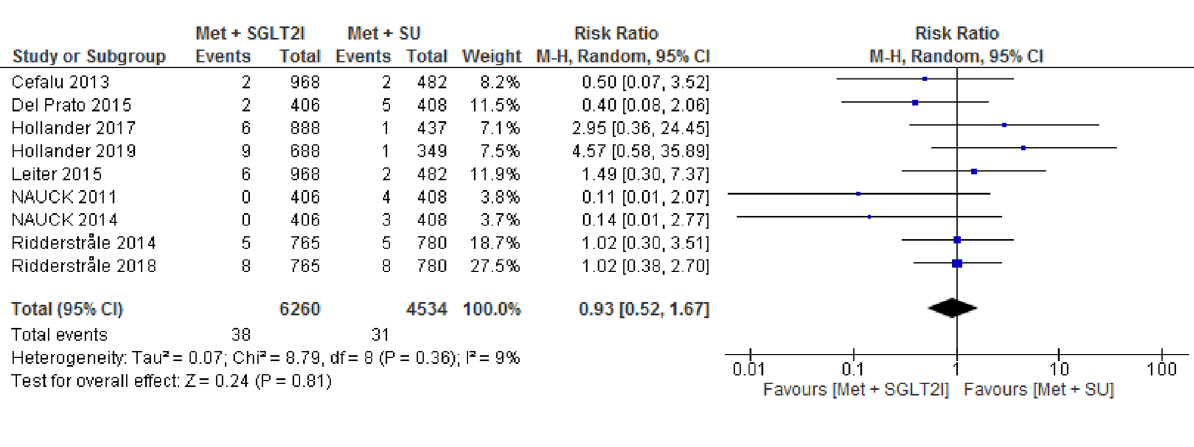
Figure 2. ’Risk of bias’ summary: review authors’ judgments about each ’risk of bias’ item for included trials. Green cells = ‘low risk’; blank cells = ‘unclear risk’; red cells = ‘high risk’.